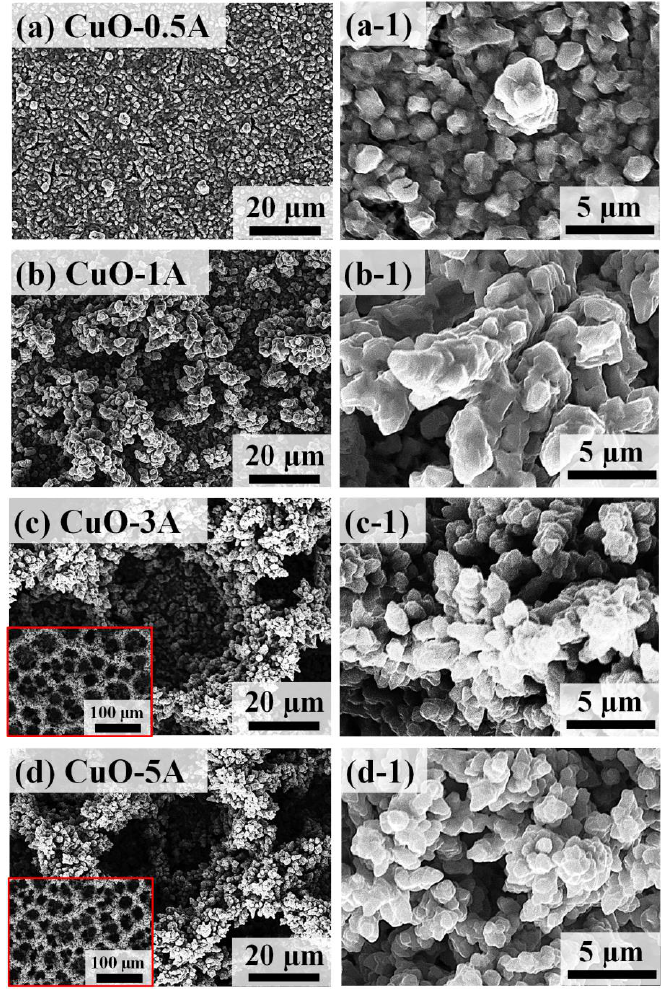
Figure 5. SEM images of porous CuO nanostructures based on the control of current density between 0.5 and 5 A (CuO-0.5A ~ CuO-5A) for the fixed time of 30 s. ( a – d ) Large scale SEM images of the CuO